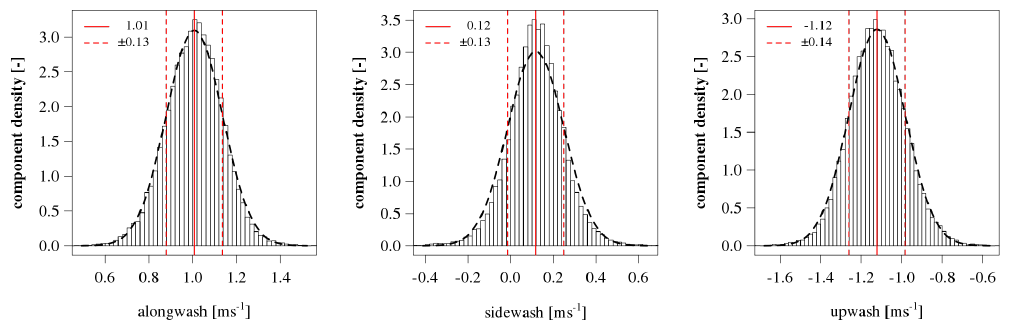
Fig. 5. Histograms of wing-generated alongwash, sidewash and upwash at the five hole probe location. Results are calculated from wing properties in Eqs. (1)–(3) and then rotated from wing- into trike body coordinates (Fig. 2) using Eq. (A13). Presented is the same dataset and in the same manner as in Fig. 4.